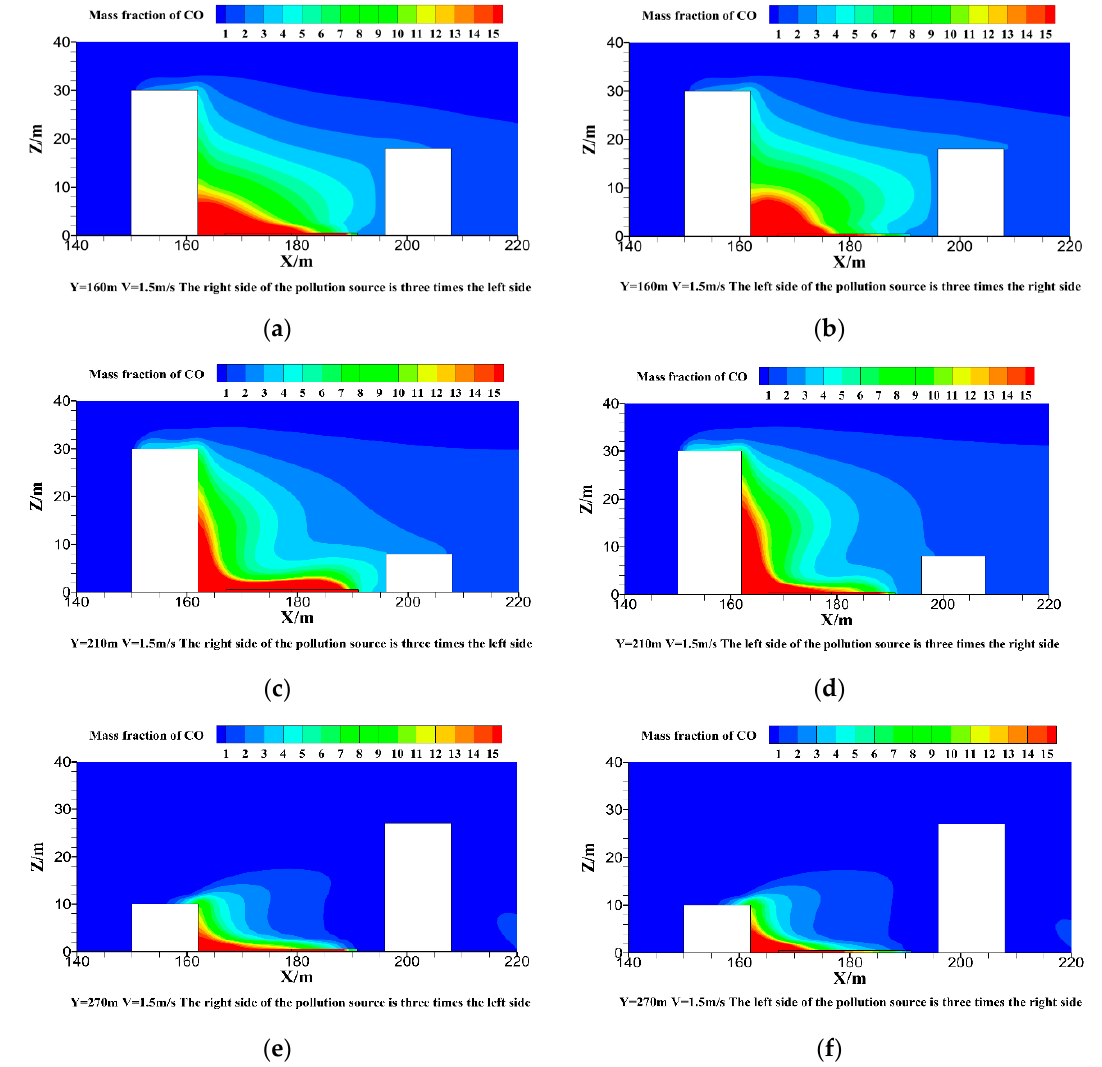
Figure 8. CO concentration field profile (10 − 9 ) in three different sections at a wind speed of 1.5 m/s and emission ratios of R = 1/3 and R = 3. ( a ) Y = 160 m, R = 1/3; ( b ) Y = 160 m, R = 3; ( c ) Y = 210 m, R = 1/3; ( d ) Y = 210 m, R = 3; ( e ) Y = 270 m, R = 1/3; ( f ) Y = 270 m, R = 3.